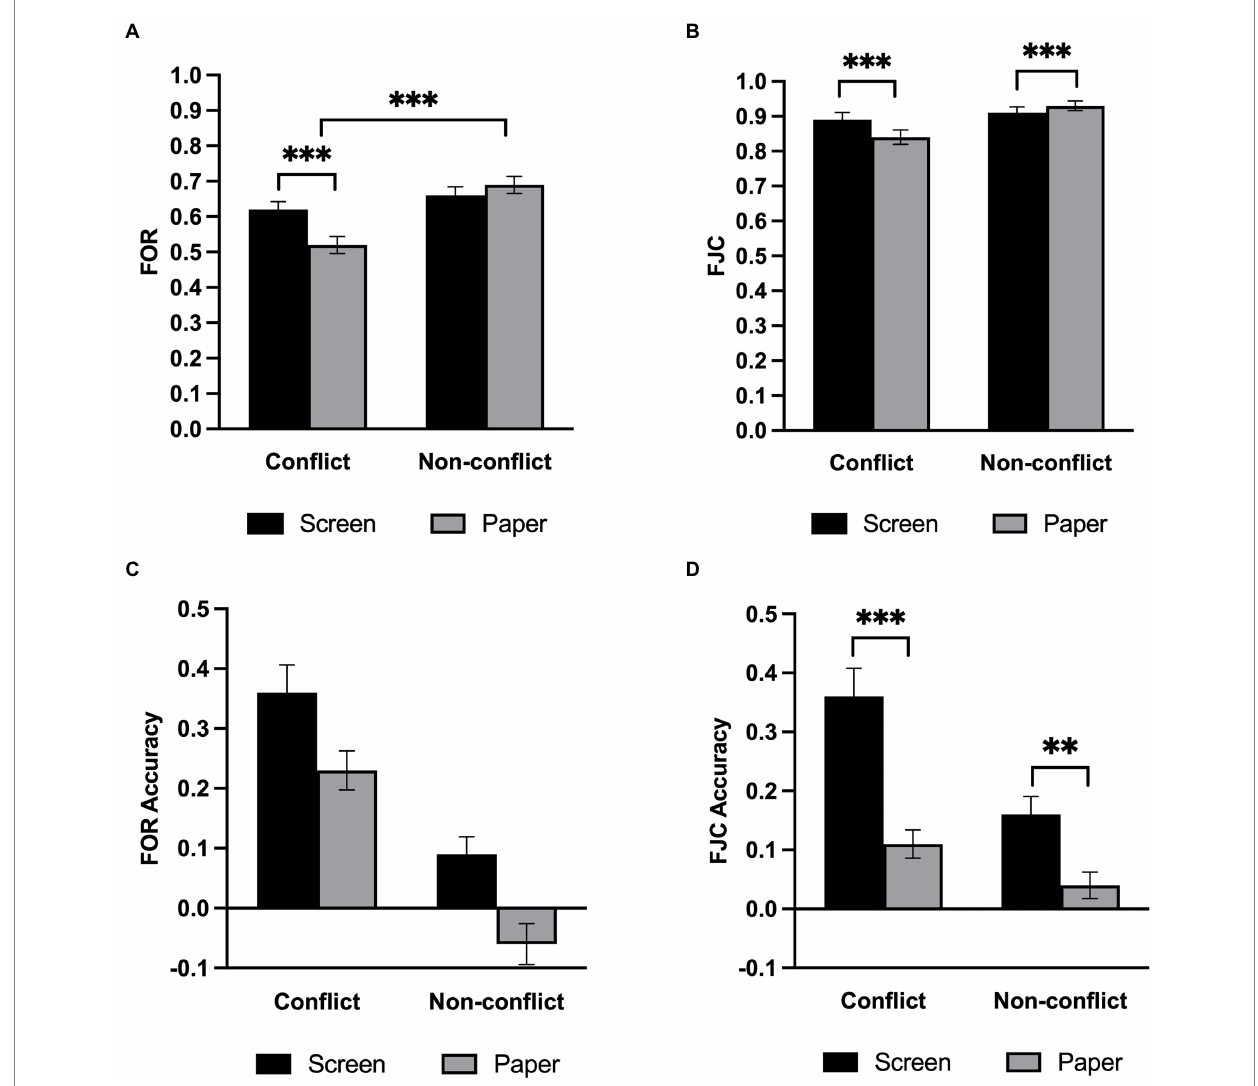
FIGURE 3 Meta-reasoning performance in Experiment 1. (A) FOR. (B) FOR accuracy. (C) FJC. (D) FJC accuracy. Error bars represent the standard error of the mean. ** p < 0.01. *** p <